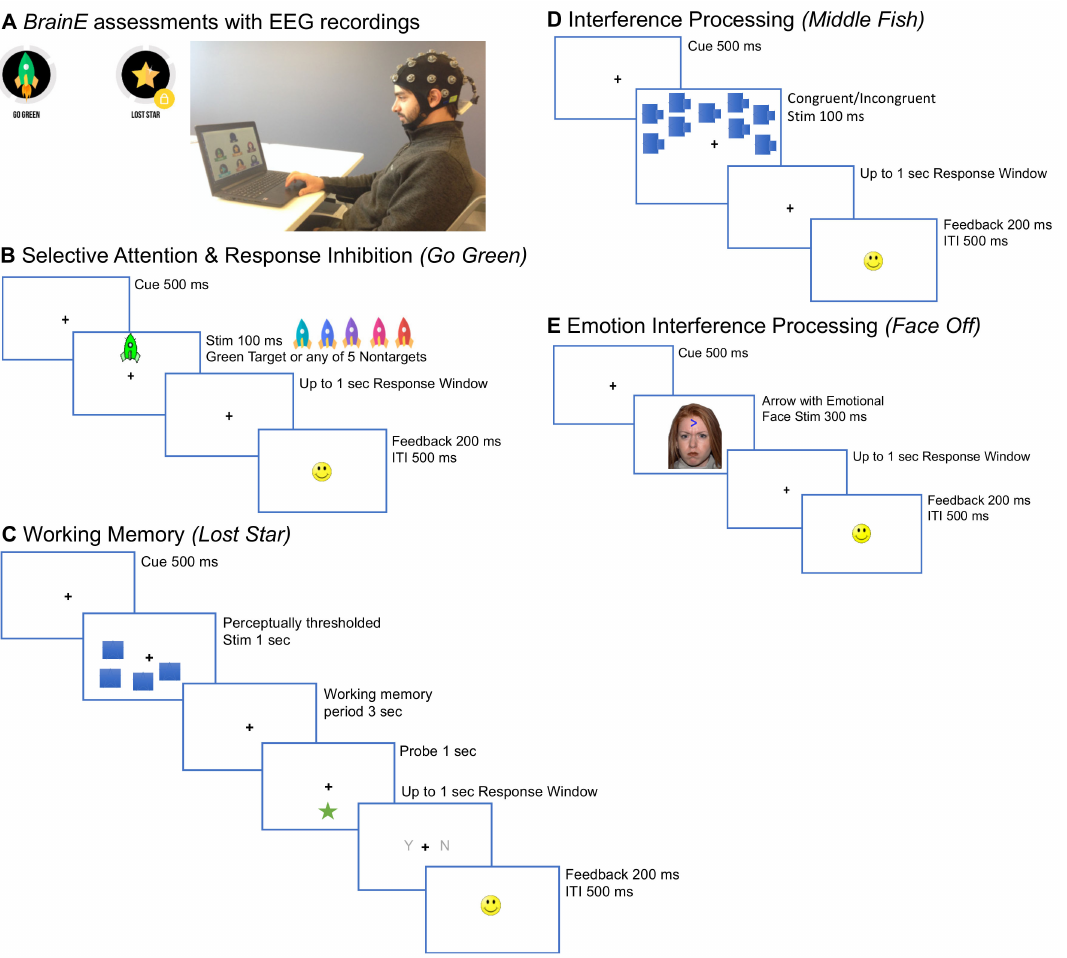
Figure 1. Cognitive assessments delivered on the BrainE platform (adapted from [12]). ( A ) BrainE assessment dashboard with the wireless EEG recording setup. ( B ) The selective attention and response inhibition tasks differ only in the frequency of targets; sparse 33% targets appear in the Selective Attention block and frequent 67% targets appear in the Response Inhibition block. ( C ) Working memory task with perceptually thresholded stimuli. ( D ) Flanker interference processing task; flanking fish may either face the same direction as the middle fish in congruent trials, or the opposite direction in incongruent trials. ( E ) Emotion interference task presents neutral, happy, sad, or angry faces superimposed on an